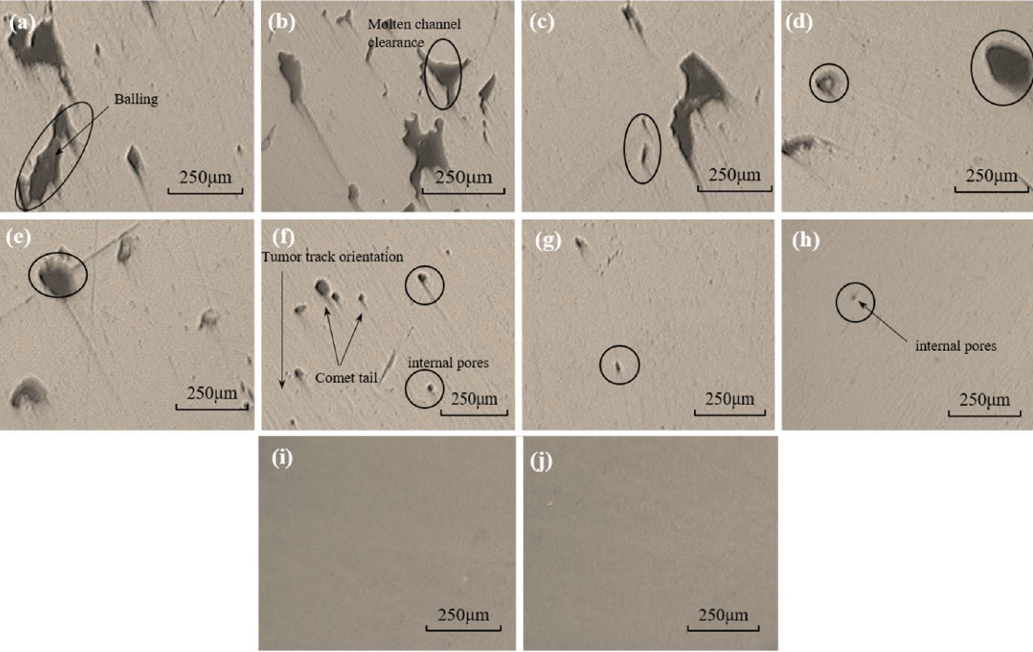
Fig. 9. Microscopic appearance under different polishing times: (a) 0.5 h, (b) 1 h, (c) 1.5 h, (d) 2 h, (e) 2.5 h, (a) 3 h, (b) 3.5 h, (c) 4 h, (d) 4.5 h, (e) 5 h.